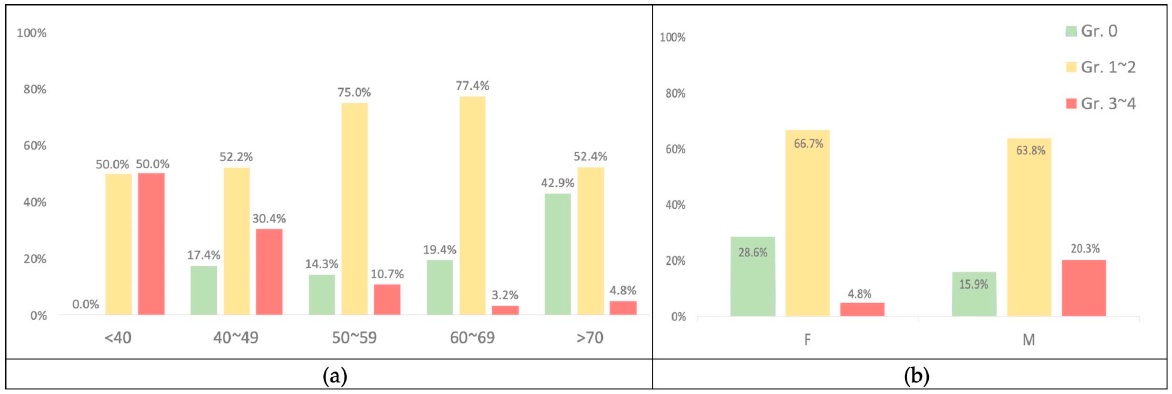
Figure 4. ( a ) The percentage according to age with acne. ( b ) The percentage according to gender with acne.